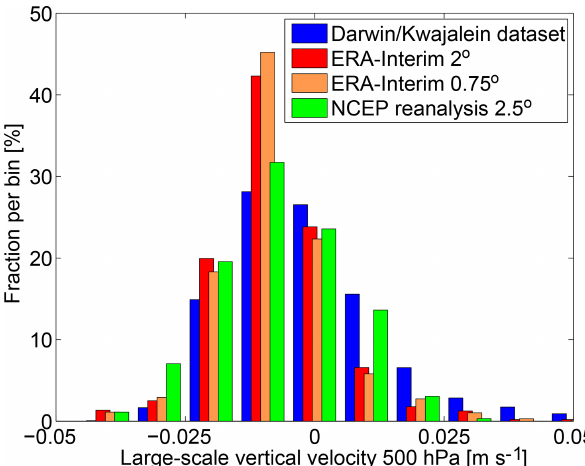
Figure 5. Frequency distribution of the vertical velocities at 500hPa of the Darwin–Kwajalein dataset compared to frequency distri- butions of the vertical velocity from the ERA-Interim reanalysis (0 . 75 ◦ × 0 . 75 ◦ and 2 ◦ × 2 ◦ horizontal resolution) and the NCEP reanalysis (2 . 5 ◦ × 2 . 5 ◦ horizontal resolution). For the reanalysis data, the vertical velocity at 500hPa at all grid points between 180 and 240 ◦ E and between 30 ◦ S and 30 ◦ N (Pacific Ocean) for the arbitrary date 1 June 2010 at 00:00UTC is used. Bin width is 0.01ms − 1